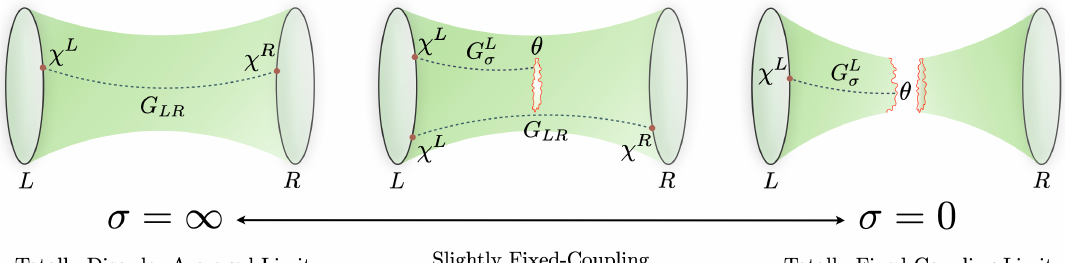
Figure 5 . The intuitive bulk pictures dual to the half-wormholes for various values of σ in the partially fixed-coupling SYK model. The left picture corresponds to the totally disorder-averaged limit σ = ∞ , where the half-wormhole and the wormhole saddles degenerate. The middle corresponds to the slightly fixed-coupling parameter region, where the half-wormhole saddles can be considered as a small perturbation of the wormhole saddle. The right picture represents the half-wormhole in the totally fixed-coupling limit, where the correlation between the left and the right boundaries totally